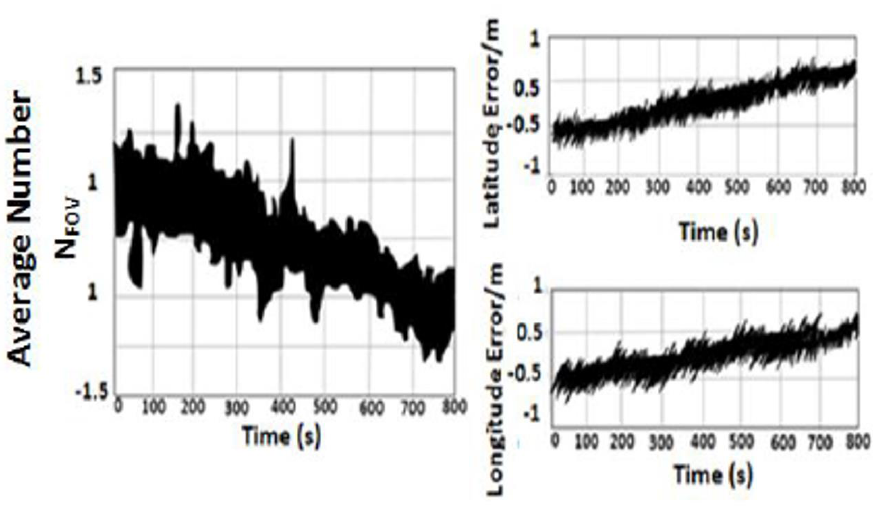
Figure 3. Experimental test of VNBM Accuracy.